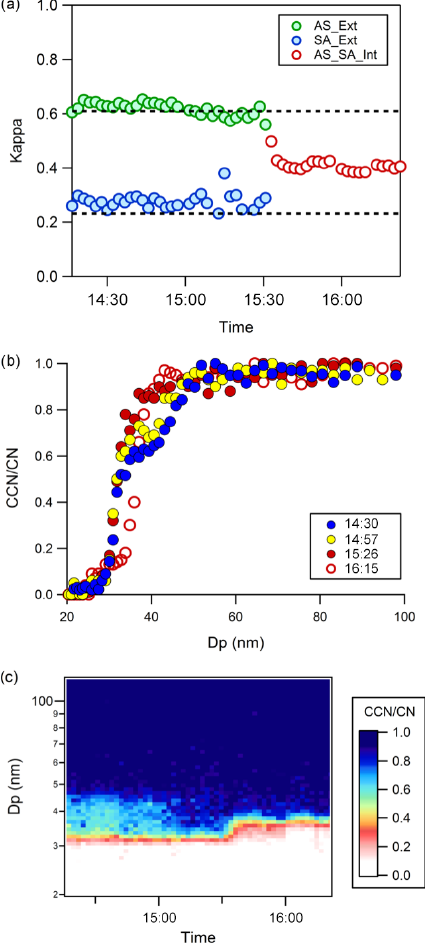
Figure 4. External to internal mixtures of a slightly soluble or- ganic aerosol, succinic acid (SA), and inorganic ammonium sul- fate (AS) aerosol. The CCNC was operated at a single S c of 0.8%. Closed symbols are externally mixed. Open symbols are inter- nally mixed. (a) The apparent kappa values derived from exter- nally mixed multiple-sigmoid activation data before active heating is turned off (at approximately 15:30PDT, Pacific daylight time, for all times in the paper) and single-sigmoid activation curves (after 15:30) are shown. The two dotted lines indicate the theoretically derived kappa values for succinic acid, κ = 0 . 23, and ammonium sulfate, κ = 0 . 61. (b) CCN activation curves exhibit external (with active heating before 15:30) and then transitioning external to in- ternal mixing (after 15:30) (c) CCN / CN vs. dry mobility diameter data as a function of time. The asymptote, η , disappears by the end of the